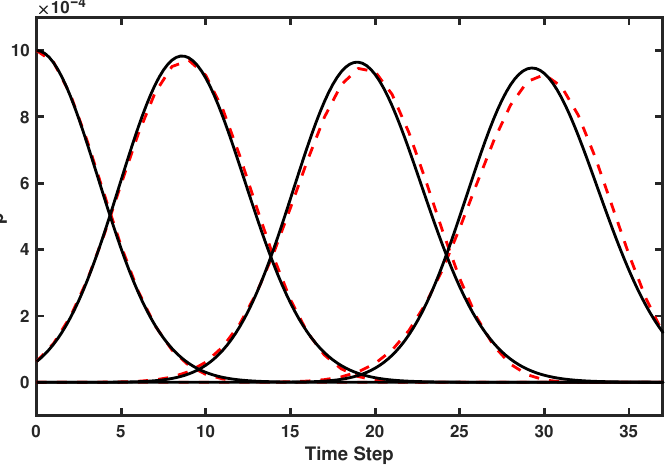
∆ x 2 ∆ t ) with σ = 0.1: ∆ x 2 = 0.1 is shown ∆ t ) with σ